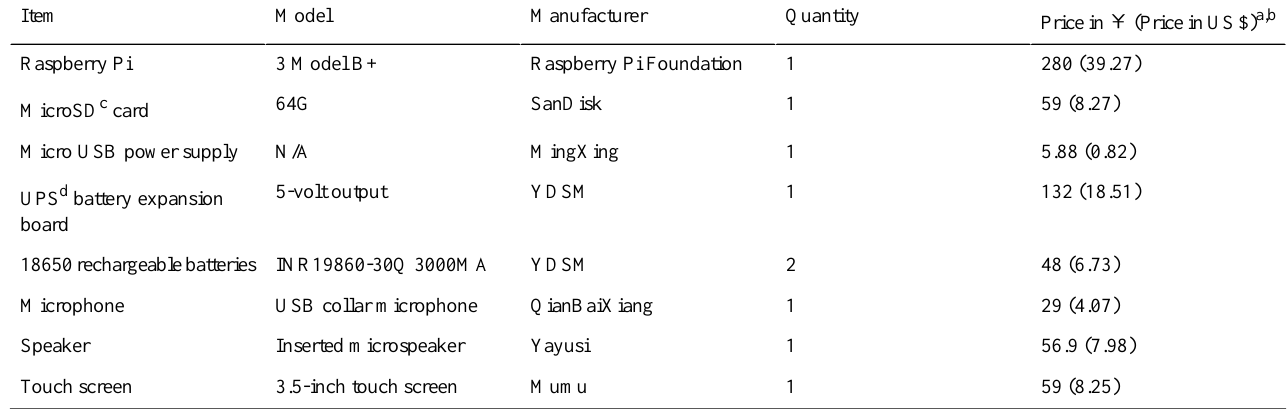
Table 1. Components of the Auscul Pi digital stethoscope.